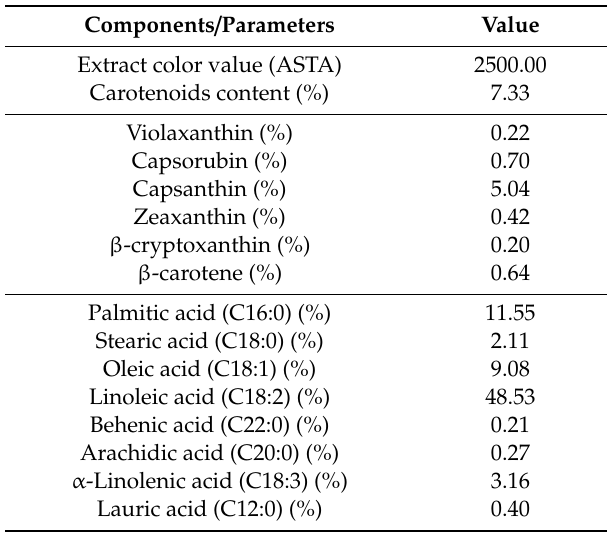
Table 1. Characteristics of paprika extract.